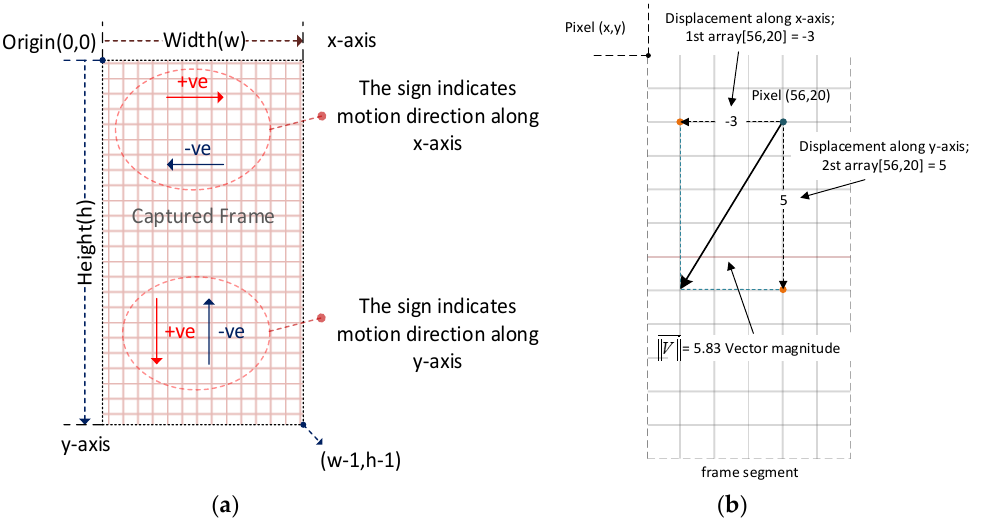
Figure 6. Image coordinates and motion vector calculation: ( a ) Image 2D coordinates, with the origin being located at the top left corner, the x -axis is pointing to the right and the y -axis is pointing downwards. The sign of the magnitude of the vector component ( x and y values) indicates the direction of motion; ( b ) Frame segment and calculating the motion vector for a single pixel.